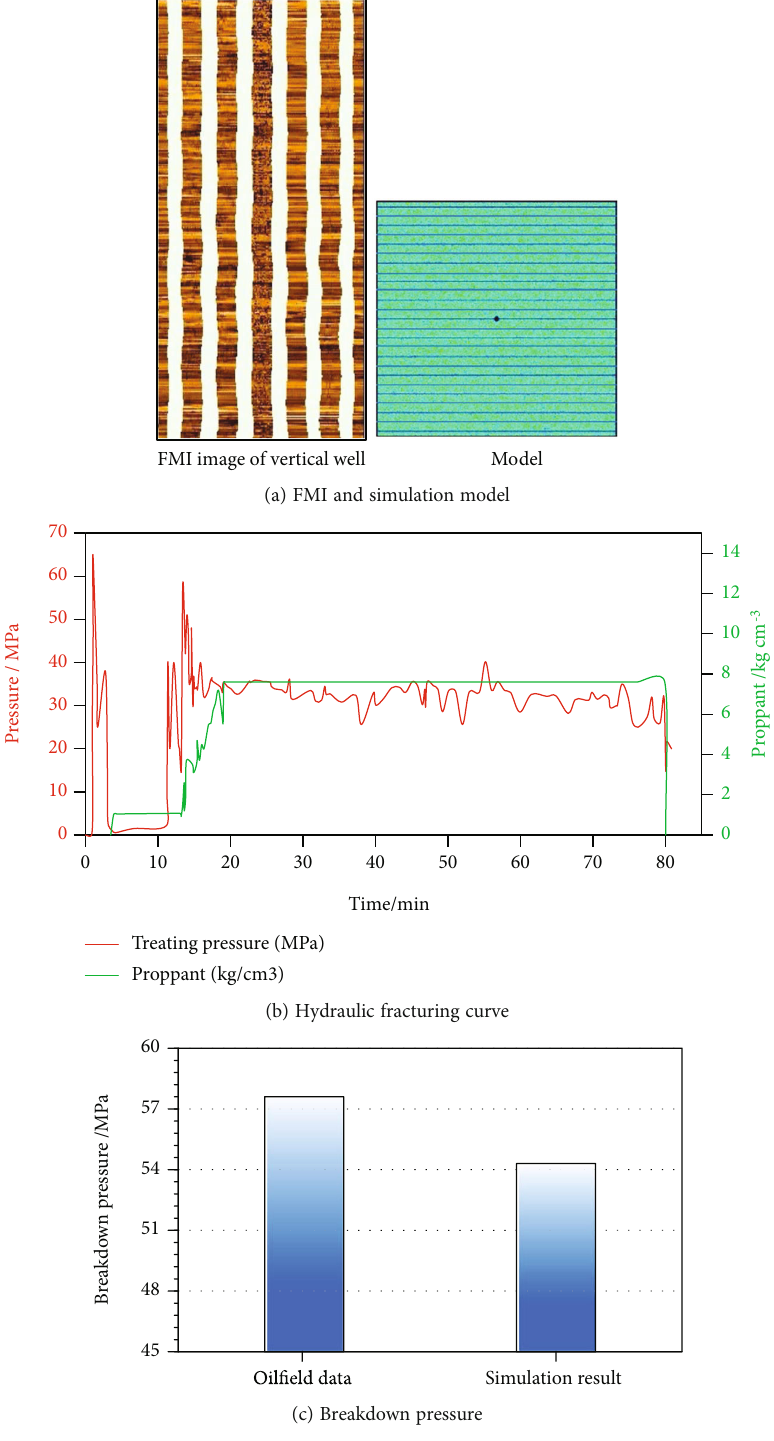
Figure 11: Comparison of breakdown pressures between oil fi eld data and simulation